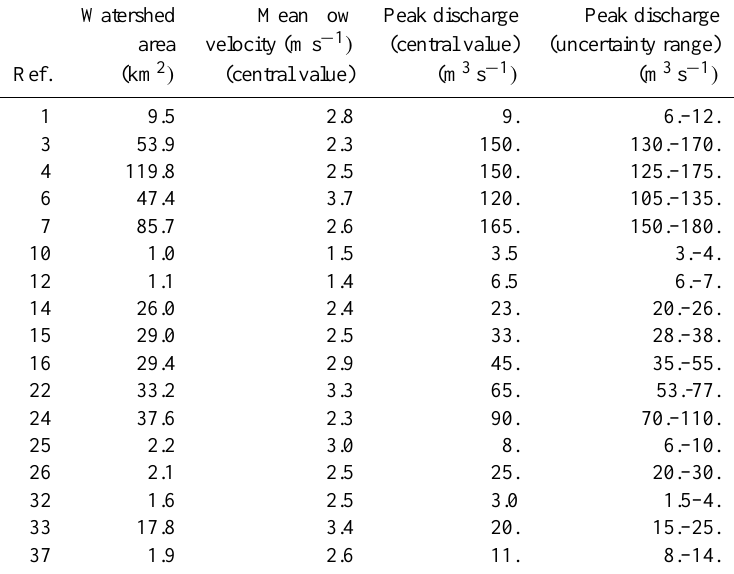
Table 1. Peak discharge estimates from the field survey. Section reference numbers are reported in Fig. 1. Watershed Mean flow Peak discharge Peak discharge area velocity (ms − 1 ) (central value) (uncertainty